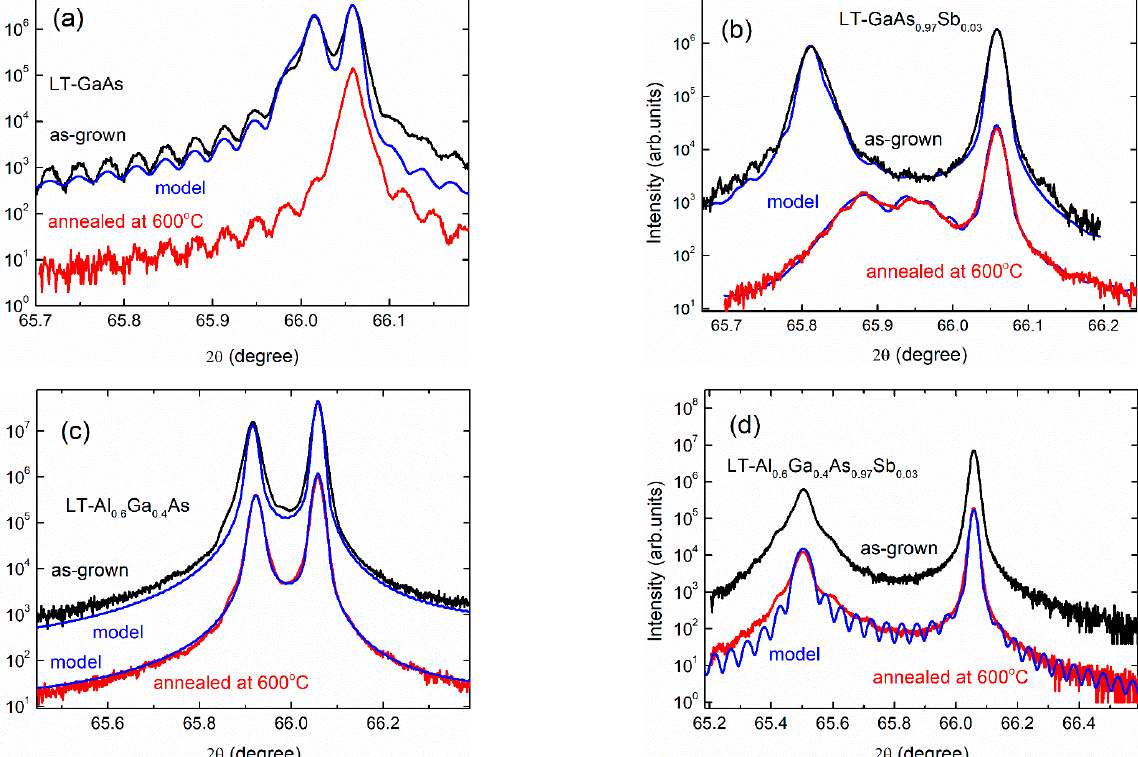
Figure 1. Experimental (black and red curves) and simulated (blue curves) XRD profiles around the 004 reflection of the GaAs substrate with ( a ) LT-GaAs, ( b ) LT-GaAs 0.97 Sb 0.03 , ( c ) LT-Al 0.6 Ga 0.4 As and ( d ) LT-Al 0.6 Ga 0.4 As 0.97 Sb 0.03 layers before (black curves) and after (red curves) annealing at 600 ◦ C. The curves related to the as-grown sample are shifted up for clarity. The annealing at 600 ◦ C causes a shift of the LT-layer-related XRD peak to larger angles. It indicates a decrease in the lattice parameter due to precipitation of the excess